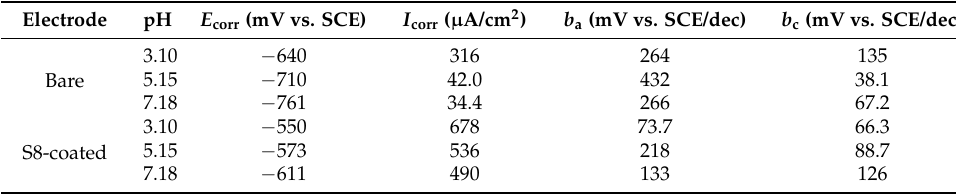
Table 1. Parameters calculated by potentiodynamic polarization curve.